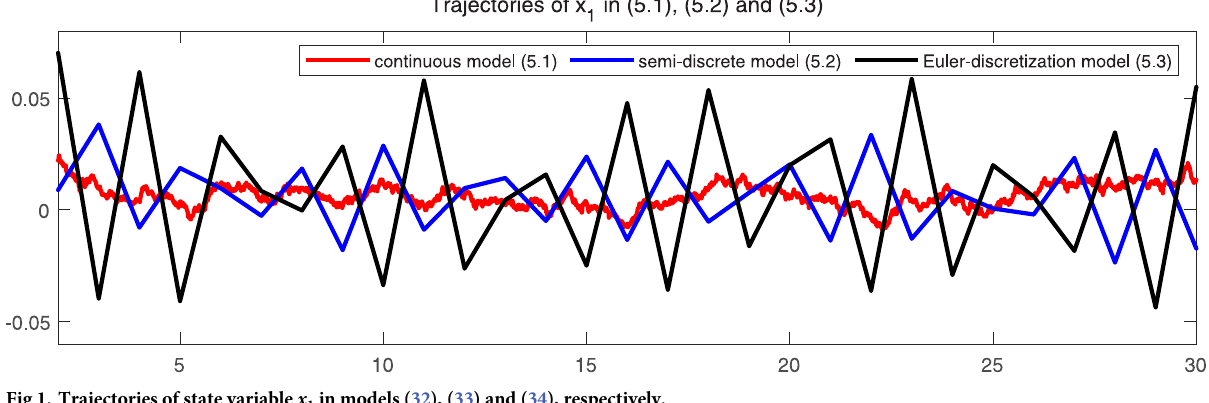
Fig 1. Trajectories of state variable x 1 in models (32), (33) and (34), respectively.